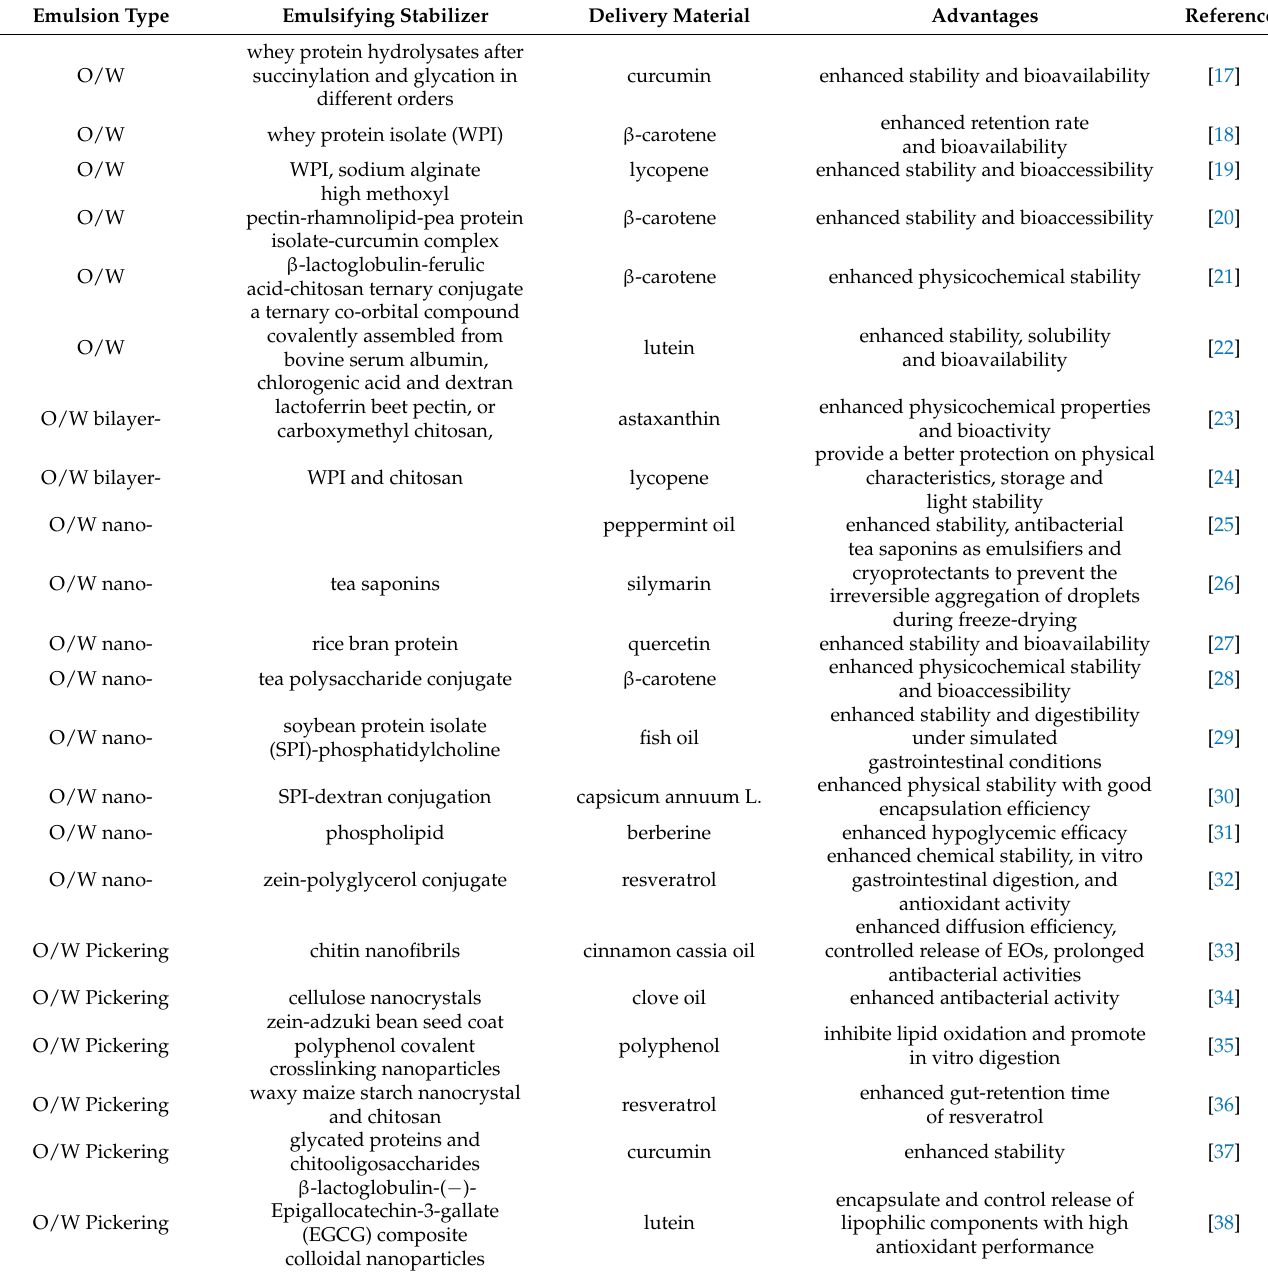
Table 1. Applications of food-grade emulsions in soft matter